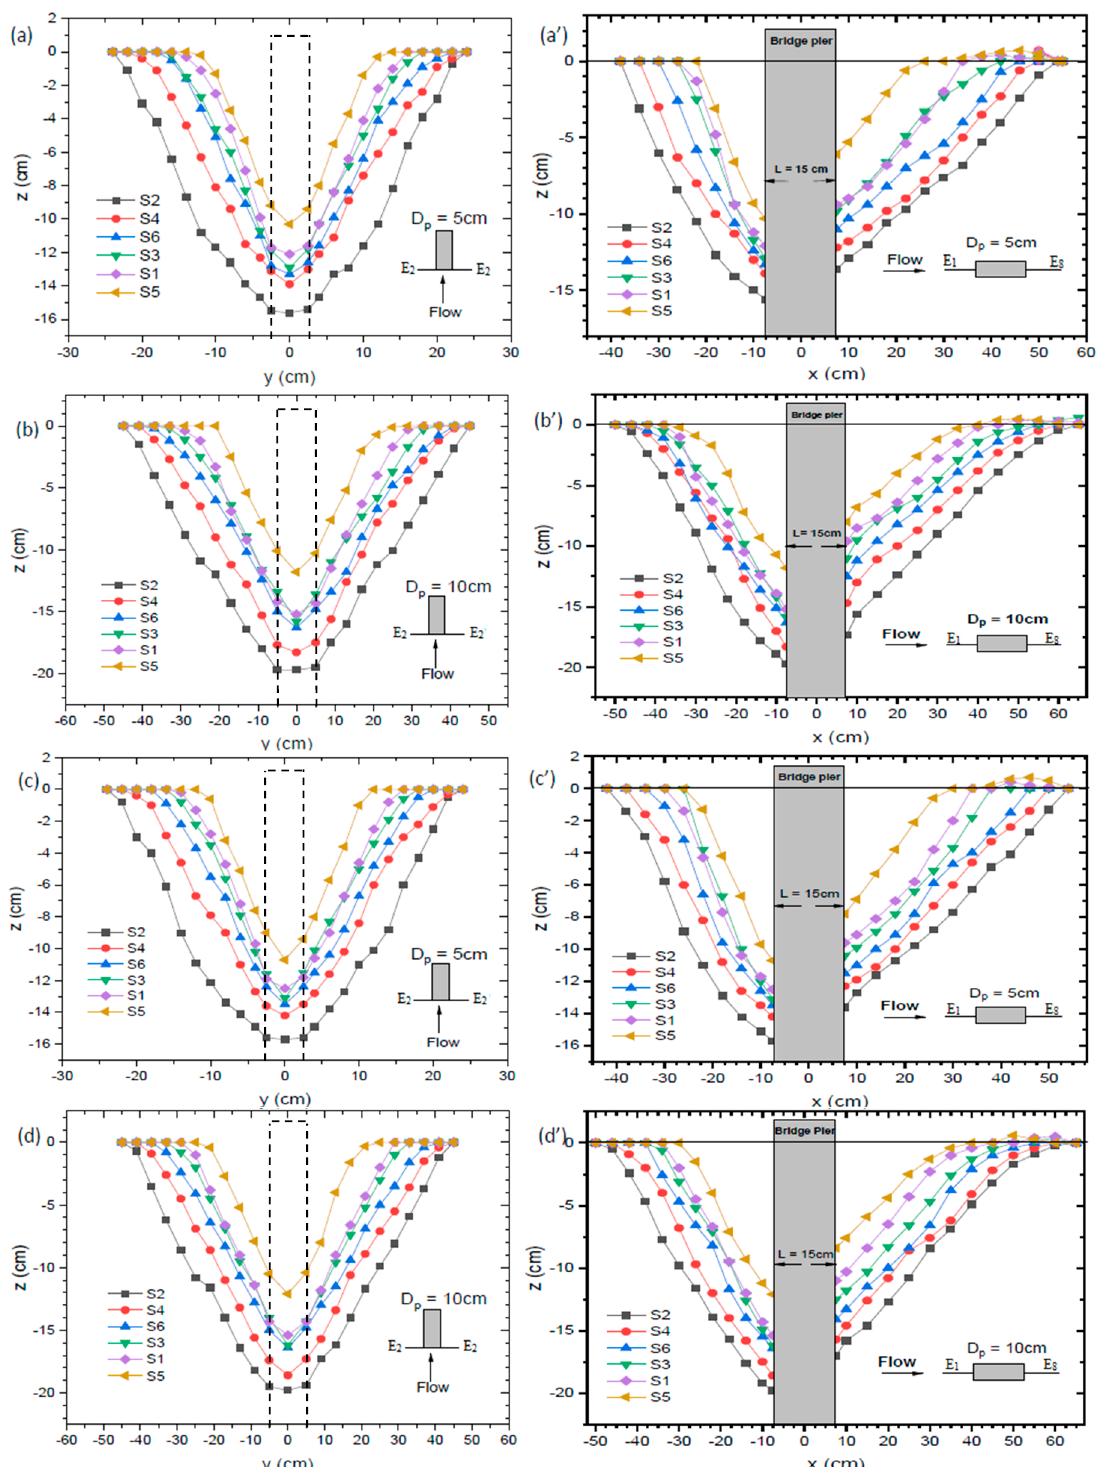
Figure 6. Scour profiles aligned with section E 2 –E 2 and section E 1 –E 8 for different pier shapes ( a ), ( a' ), ( b ) and ( b’ ) for d 50 = 0.71 mm; ( c ), ( c’ ), ( d ) and ( d’ ) for d 50 = 0.98 mm.